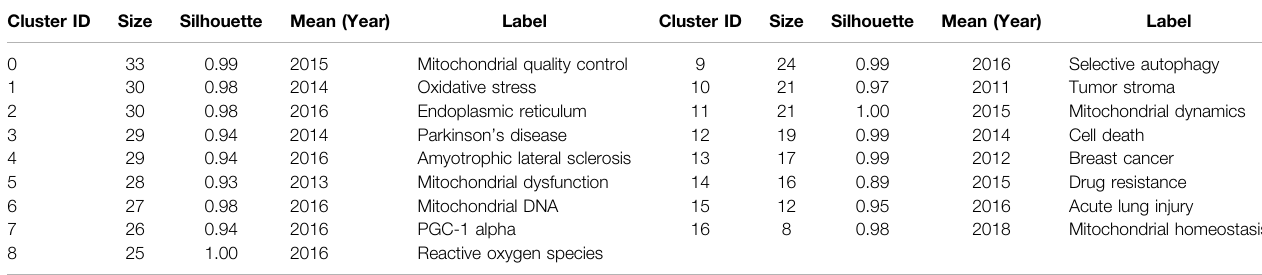
TABLE 6 | Top 17 largest clusters of keywords in the fi eld of mitophagy. Cluster ID